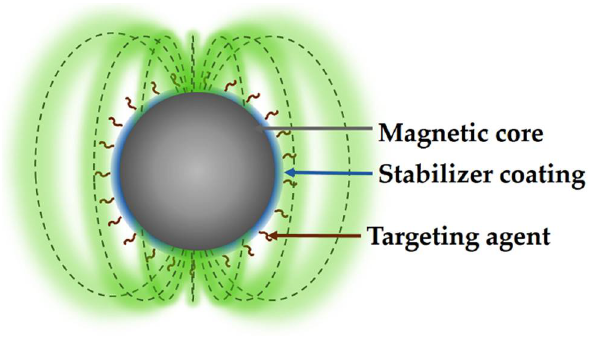
Figure 1. Structure of functionalized MNP for medical applications.